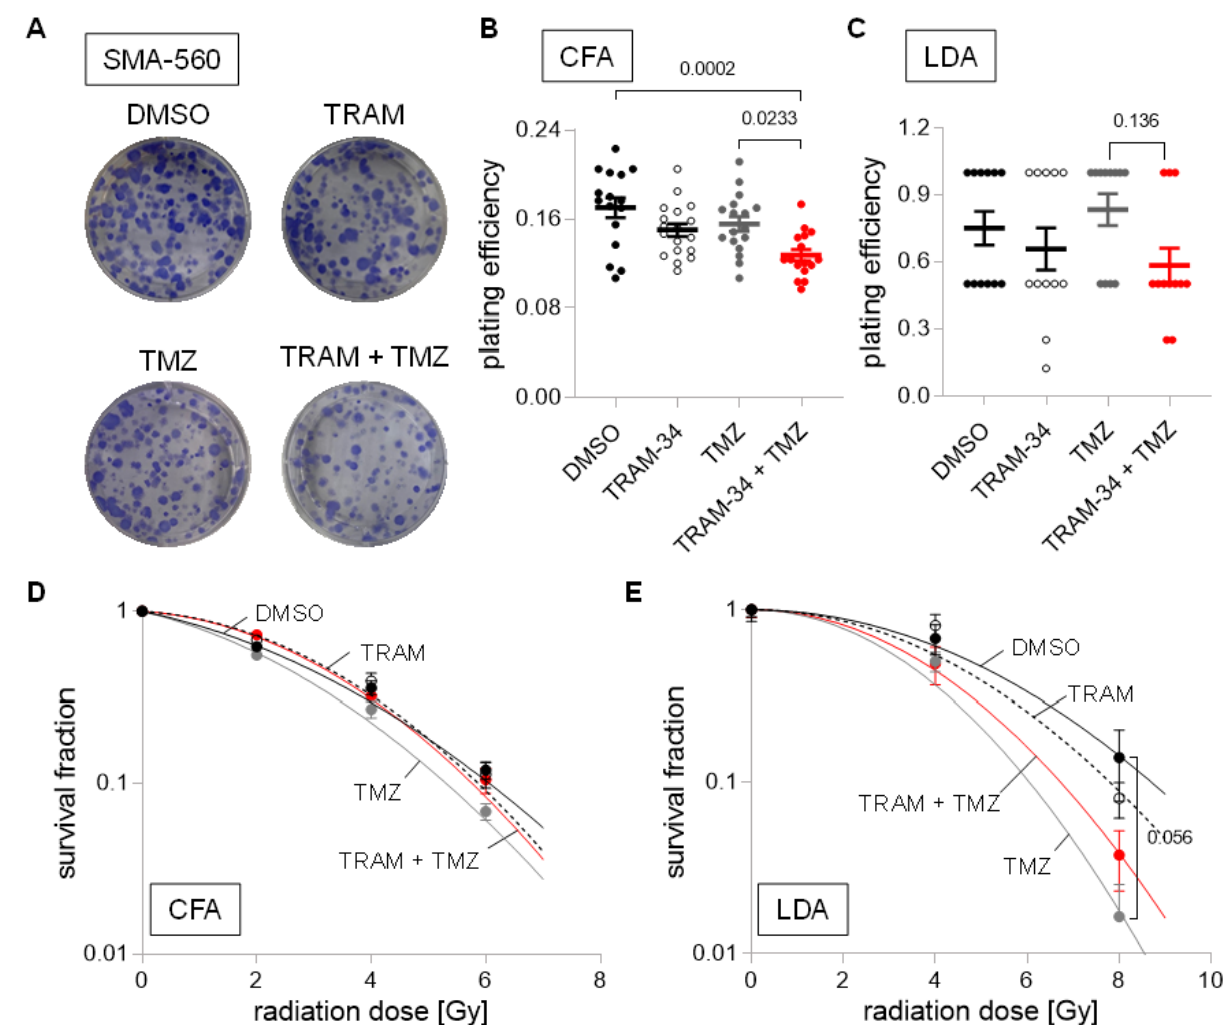
Figure 5. Cell culture condition-dependent effects of K Ca 3.1 blockade on sensitivity to irradiation and temozolomide in SMA-560 cells ( A – C ). Representative images of colony formation ( A ) and plating efficiencies ( B ) of DMEM-grown or ( C ) NSC-grown cells after irradiation with 0 Gy and co-treatment with vehicle (DMSO, closed black circles), TRAM-34 (5 µ M, open circles), temozolomide (TMZ, 30 µ M, closed grey circles), or TRAM-34 (5 µ M) together with temozolomide (TMZ, 30 µ M, closed red circles) ( D , E ) Survival fractions of irradiated (0–8 Gy) cells co-treated with vehicle (DMSO, closed black circles), TRAM-34 (5 µ M, open circles), temozolomide (TMZ, 30 µ M, closed grey circles), or TRAM-34 (5 µ M) together with temozolomide (TMZ, 30 µ M, closed red circles) as determined by colony formation assay for DMEM-grown ( D ) and limited dilution assay for NSC-grown SMA-560 cells ( E ). Data are individual values in ( B , C ) and mean ± standard error in ( B – E ) of three experimental units with four to six observational units each. Survival fraction curves were fitted according to the linear quadratic model and given as follows: DMSO, solid black line; TRAM-34, dashed line; temozolomide, solid grey line; TRAM-34 and TMZ, solid red line. Numbers in ( B , C , E ) indicate error probabilities ( p values) as calculated with one-way ANOVA and Tukey multiple comparison